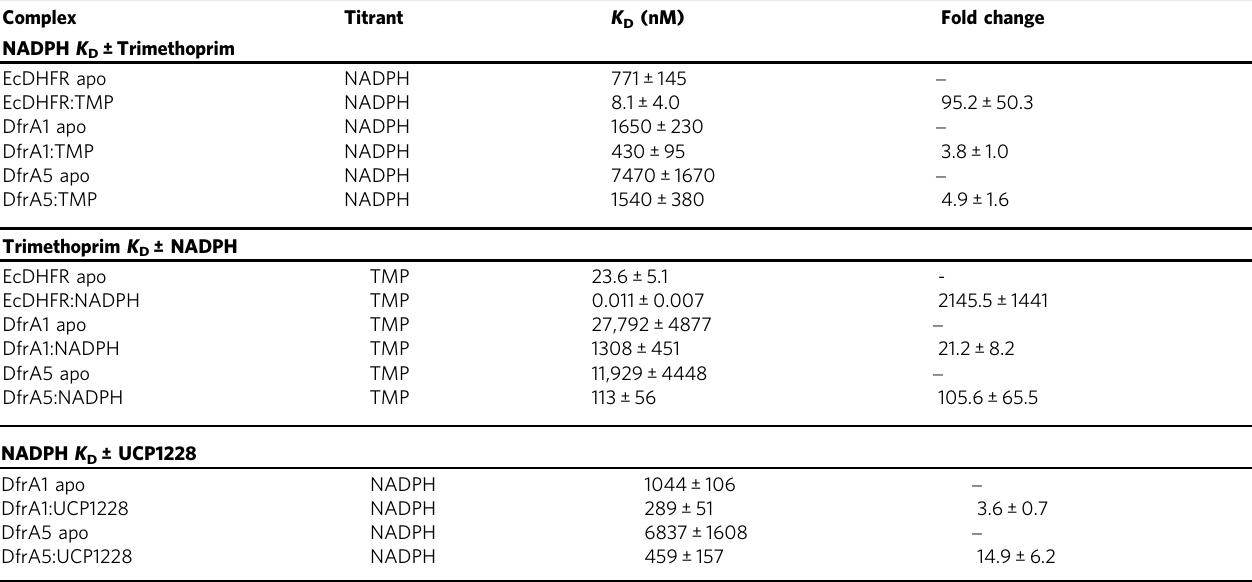
Table 5 Binding af fi nity data of NADPH and TMP to EcDHFR, DfrA1 and DfrA5 by microscale thermophoresis (MST).